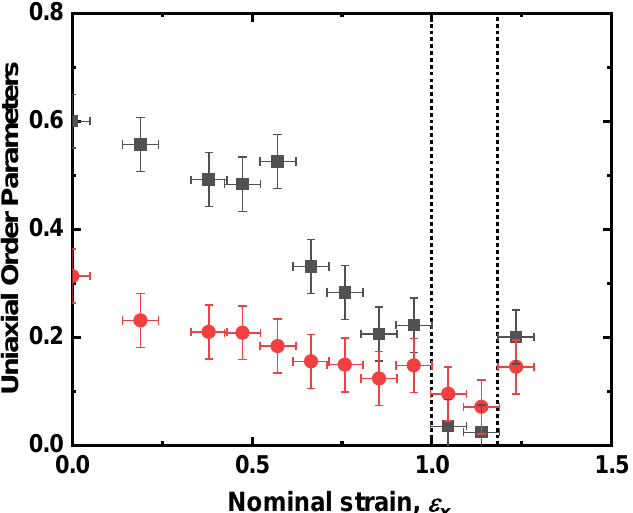
Figure 5. The uniaxial order parameters (cid:104) P 200 (cid:105) (black squares) and (cid:104) P 400 (cid:105) (red circles) as a function of the strain of the sample. The strain domain denoted by the vertical dashed lines shows the region in which (cid:104) P 200 (cid:105) appears to be lower than (cid:104) P 400 (cid:105) .